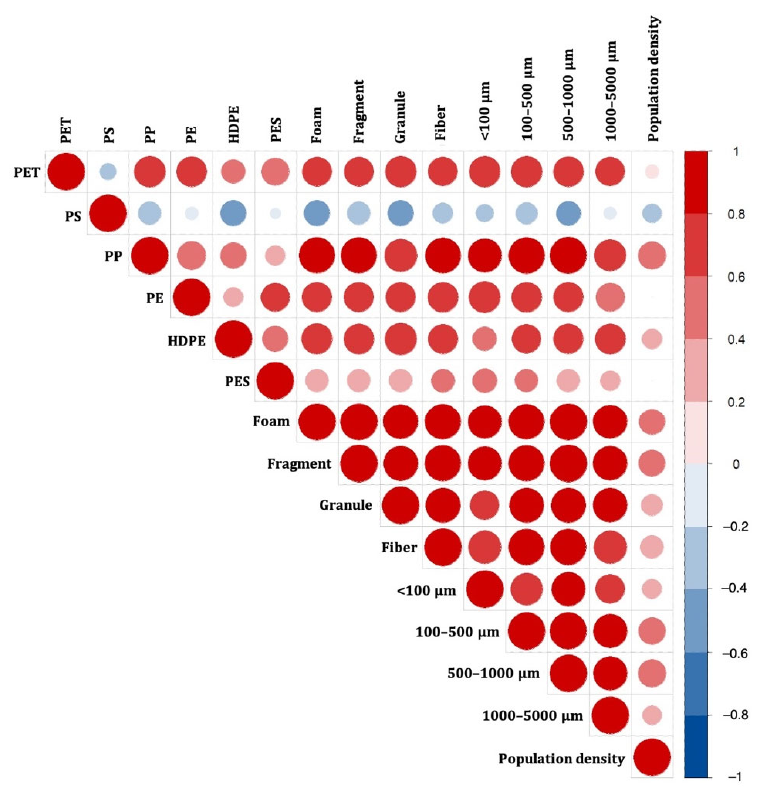
Figure 3. Spearman’s rank correlation coefficient between MP characteristics and population den ‐ sity.